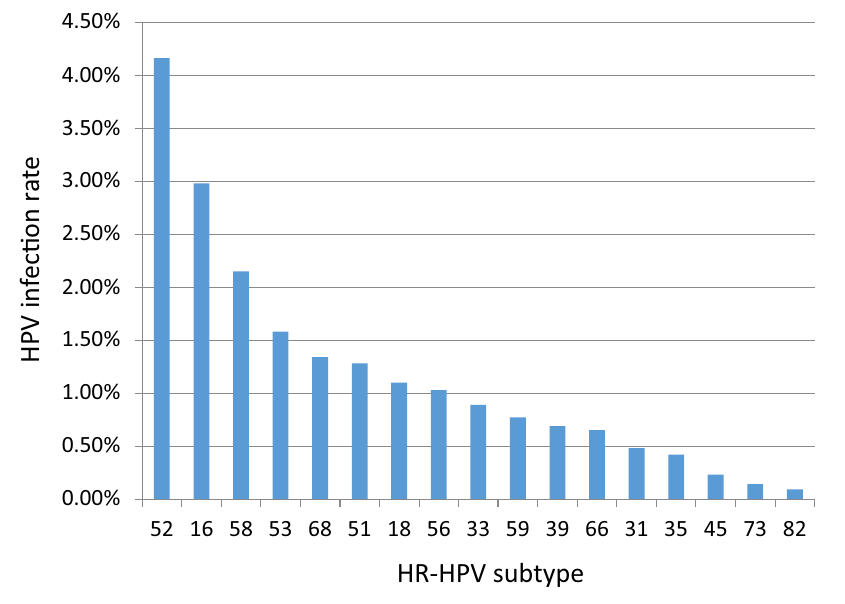
Figure 3. Distribution of HR-HPV subtypes